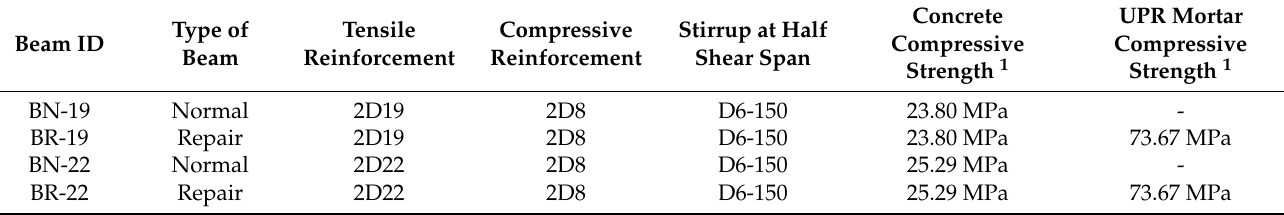
Figure 1. Two types of beam with their reinforcement layout. Table 1. Description of beam specimens.